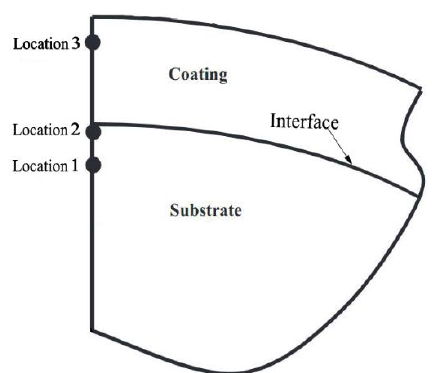
Figure 2. Schematic of the tip of a coated sphere where the three possible locations of yield inception are shown taken from [26].